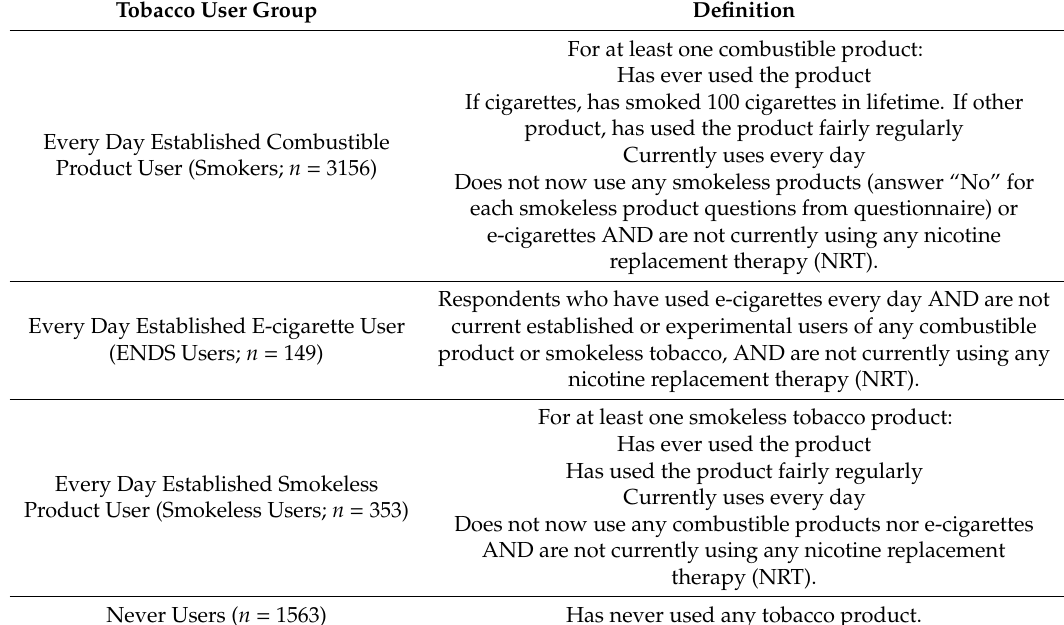
Table 1. Tobacco user group